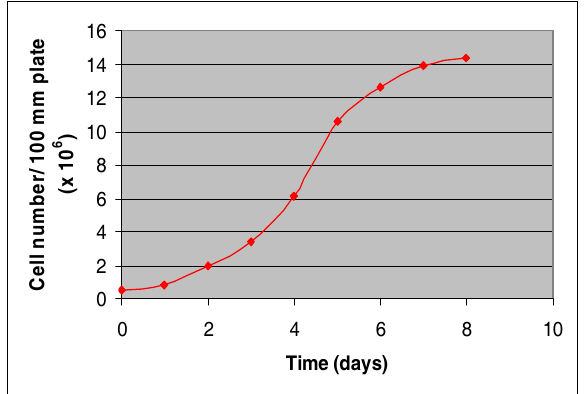
Figure 1: Time-dependent Growth. Cells were plated at a density of 5 x 10 5 cells/ml and propagated in RPMI 1640 medium supplemented with 10 % FBS (serum) and 1% pen/strep/fungisome mixture for eight days. Duplicate samples were randomly selected and counted using a hemacytometer every 24 h. Each data point represents the mean ± SEM of three independent experiments (N = 6). The doubling phase started at day 3 (3,382,500 cells) and persisted through day 5 (10,532,500) cells per 100 mm diameter plate.